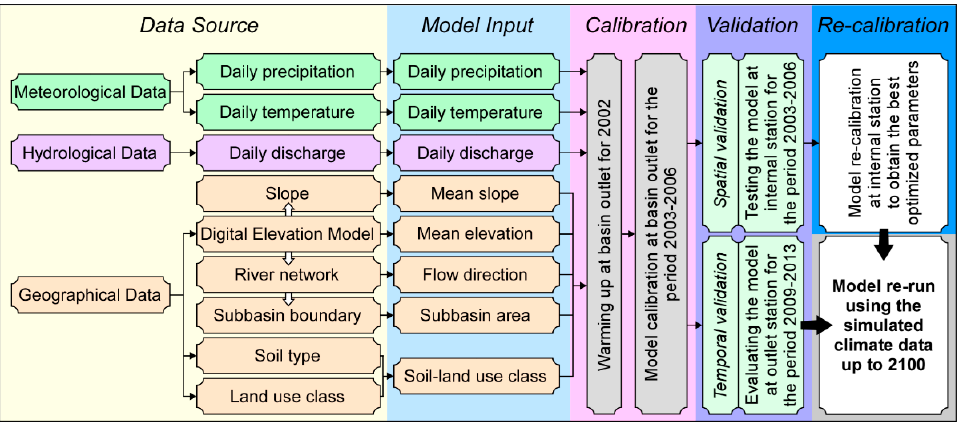
Figure 4. Flowchart depicting the data sources (see Table 2) and Hydrological Predictions for the Environment (HYPE) modelling stages used to predict discharge at the Alata River Basin (ARB) outlet and internal gauging stations. Table 2. Time-series and spatial data used to setup and evaluate the HYPE model in the Alata River Basin (ARB). The periods 2003–2006 and 2009–2013 were used for model calibration and validation,